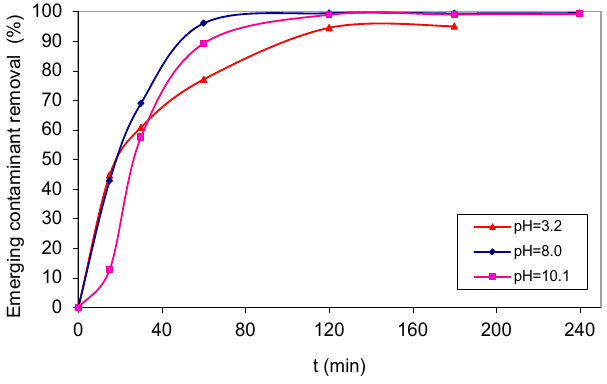
Figure 2. Influence of pH on the paracetamol removal by heterogeneous photocatalysis.